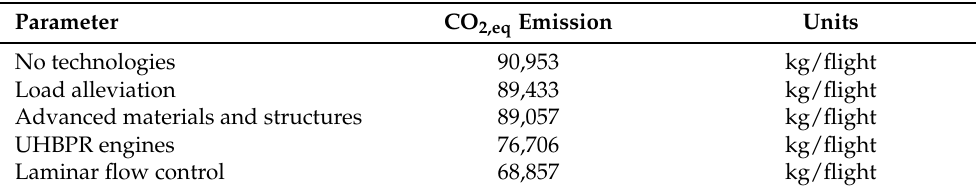
Figure 18. Technology sensitivity summary for the equivalent CO 2 emissions for the designed flight mission (Mach = 0.71, Altitude = 7600 m, maximum payload). Table 9. Equivalent CO 2 emissions for each technology applied separately at their maximum capabil- ities for the designed flight